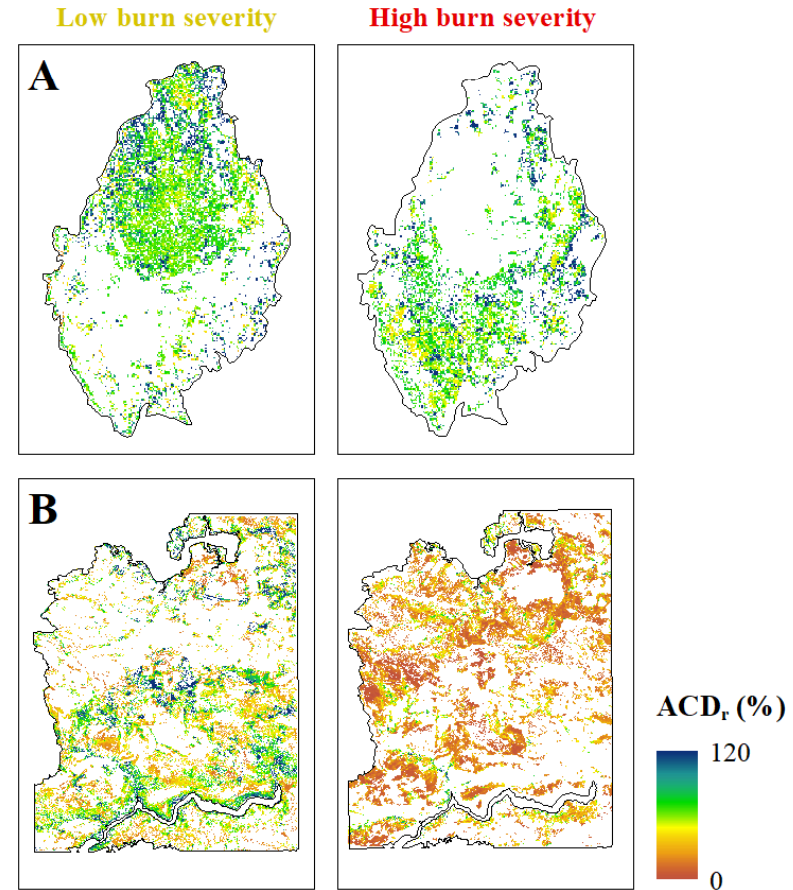
Figure 6. Maps of predicted aboveground carbon stocks recovery (ratio of post-fire to pre-fire above- ground carbon density estimates; ACD r ) of living shrub biomass as a function of burn severity in the Atlantic ( A ) and Mediterranean ( B ) sites. Blank regions not mapped in low or high burn severity scenarios correspond to masked areas with ground cover other than shrubland.